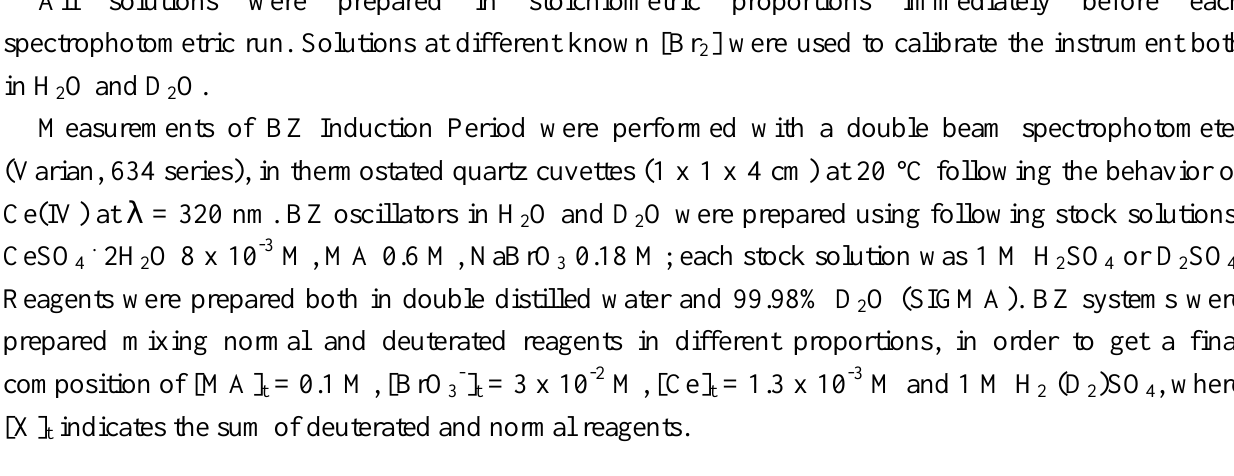
O (a) and in H O (b) at 20 °C. Temporal series 2 2 SO ] = 1 M and 2 4 [Ce] = 1.3 x 10 -3